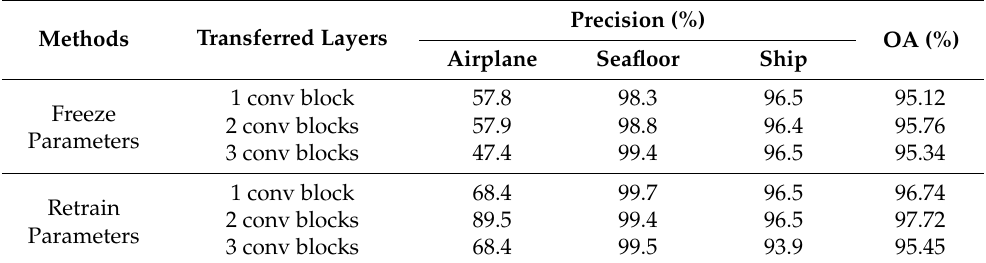
Table 5. Comparison of different transfer learning methods using SAR datasets.